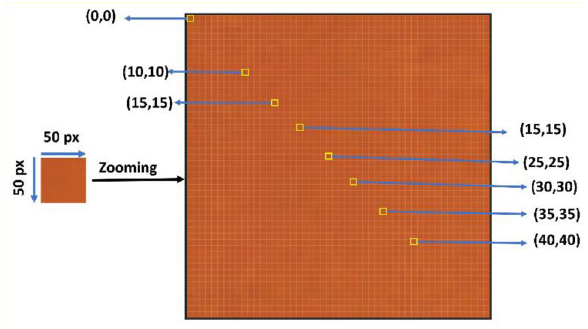
Figure 1. Pixel positions of pH paper image (at pH value = 4 , as an example).